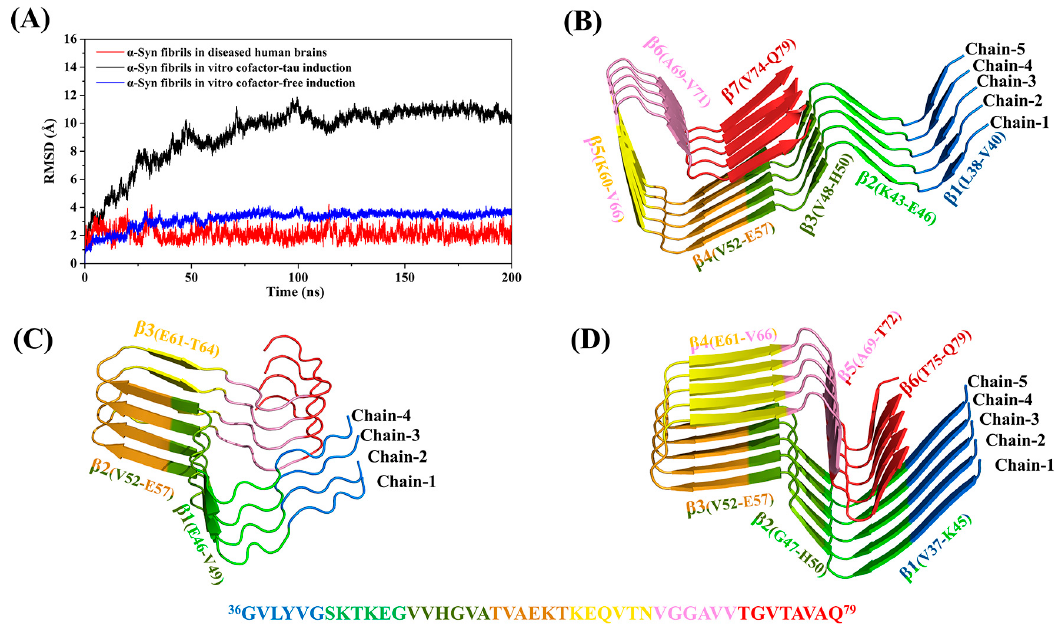
Figure 1. ( A ) The backbone RMSDs of α‐ Syn fibrils as a function of time in human brain (red), co ‐ factor ‐ tau (black), and cofactor ‐ free (blue) systems. ( B – D ) show the 3D structures of the α‐ Syn fibrils cofactor-tau (black), and cofactor-free (blue) systems. ( B – D ) show the 3D structures of the α -Syn in human brain (PDB ID: 6XYP), cofactor ‐ tau (PDB ID: 7L7H), and cofactor ‐ free (PDB ID: 6SST), fibrils in human brain (PDB ID: 6XYP), cofactor-tau (PDB ID: 7L7H), and cofactor-free (PDB ID: respectively. The amino acid sequence is color ‐ coded. The structures containing β‐ sheet are repre ‐ 6SST), respectively. The amino acid sequence is color-coded. The structures containing β -sheet are sented by β 1– β 7 in sequence. represented by β 1– β 7 in